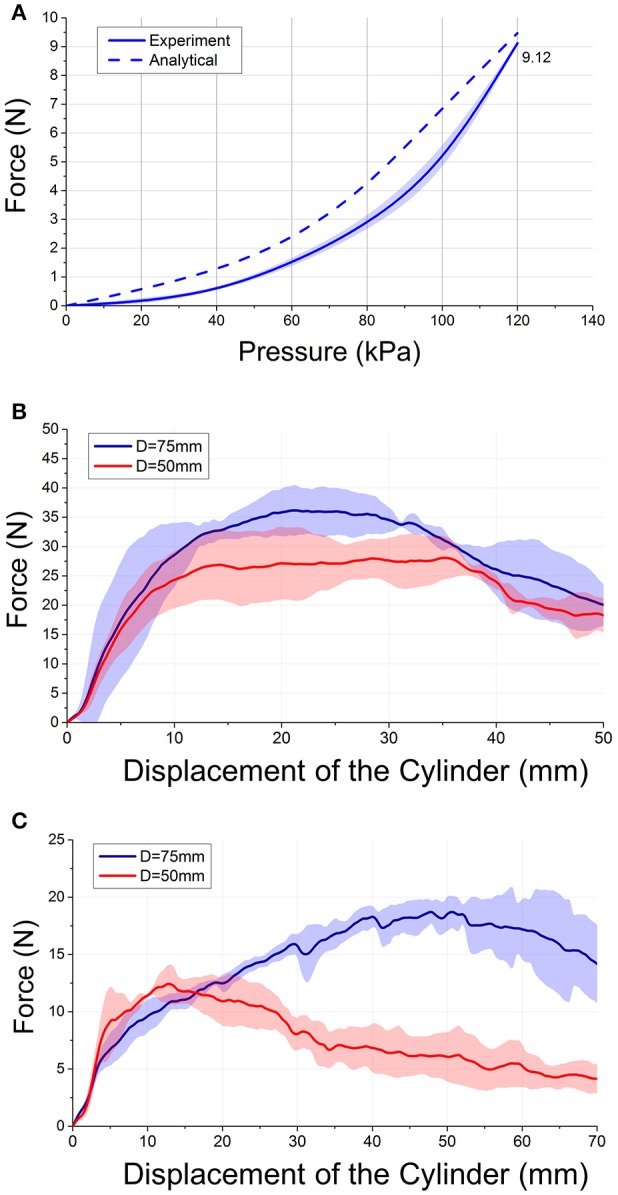
(A) Experimental and theoretical blocked tip force values over increasing pressures. (B) Normal and (C) frictional grip force output-displacement of the cylinder relationships of four actuators gripping cylinder with diameter D = 75 mm and D = 50 mm at a fixed pressure (120 kPa).